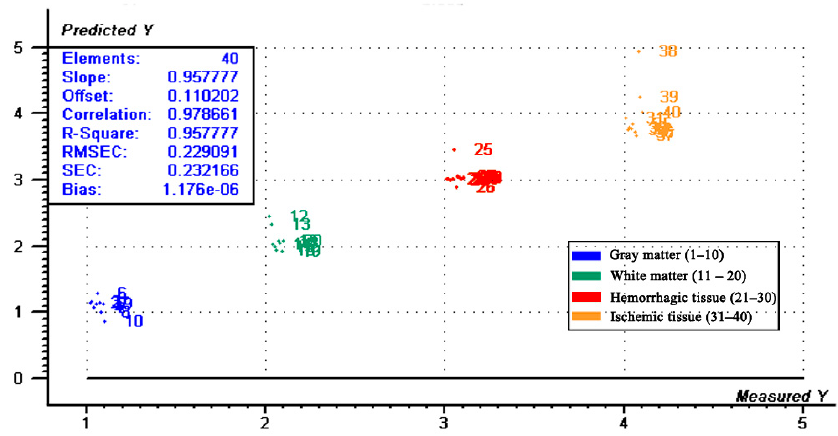
Figure 8. Regression plot of the data from the partial least squares discriminant analysis showing the first two principal components (see Figure 7).